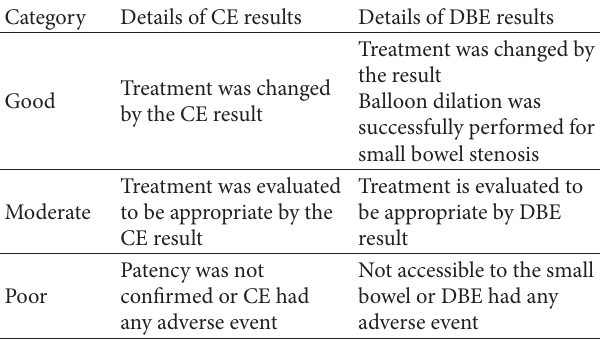
Table 1: Categorizations of CE and DBE